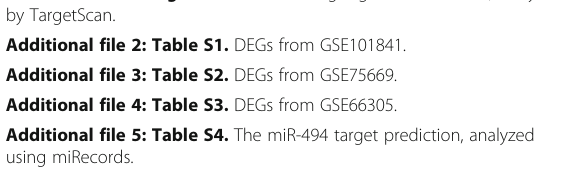
Additional file 1: Figure S1. miR-494-target gene interactions, analyzed by TargetScan. Additional file 2: Table S1. DEGs from GSE101841. Additional file 3: Table S2. DEGs from GSE75669. Additional file 4: Table S3. DEGs from